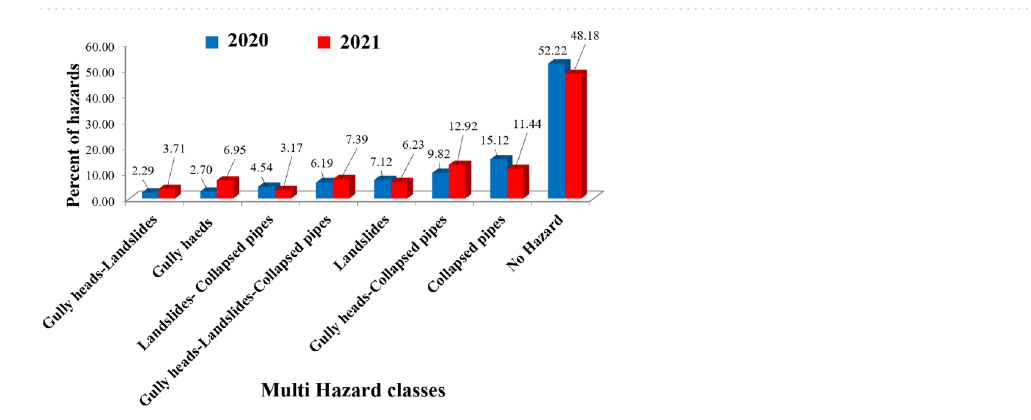
Figure 4. Percentage of each hazard in 2020 and